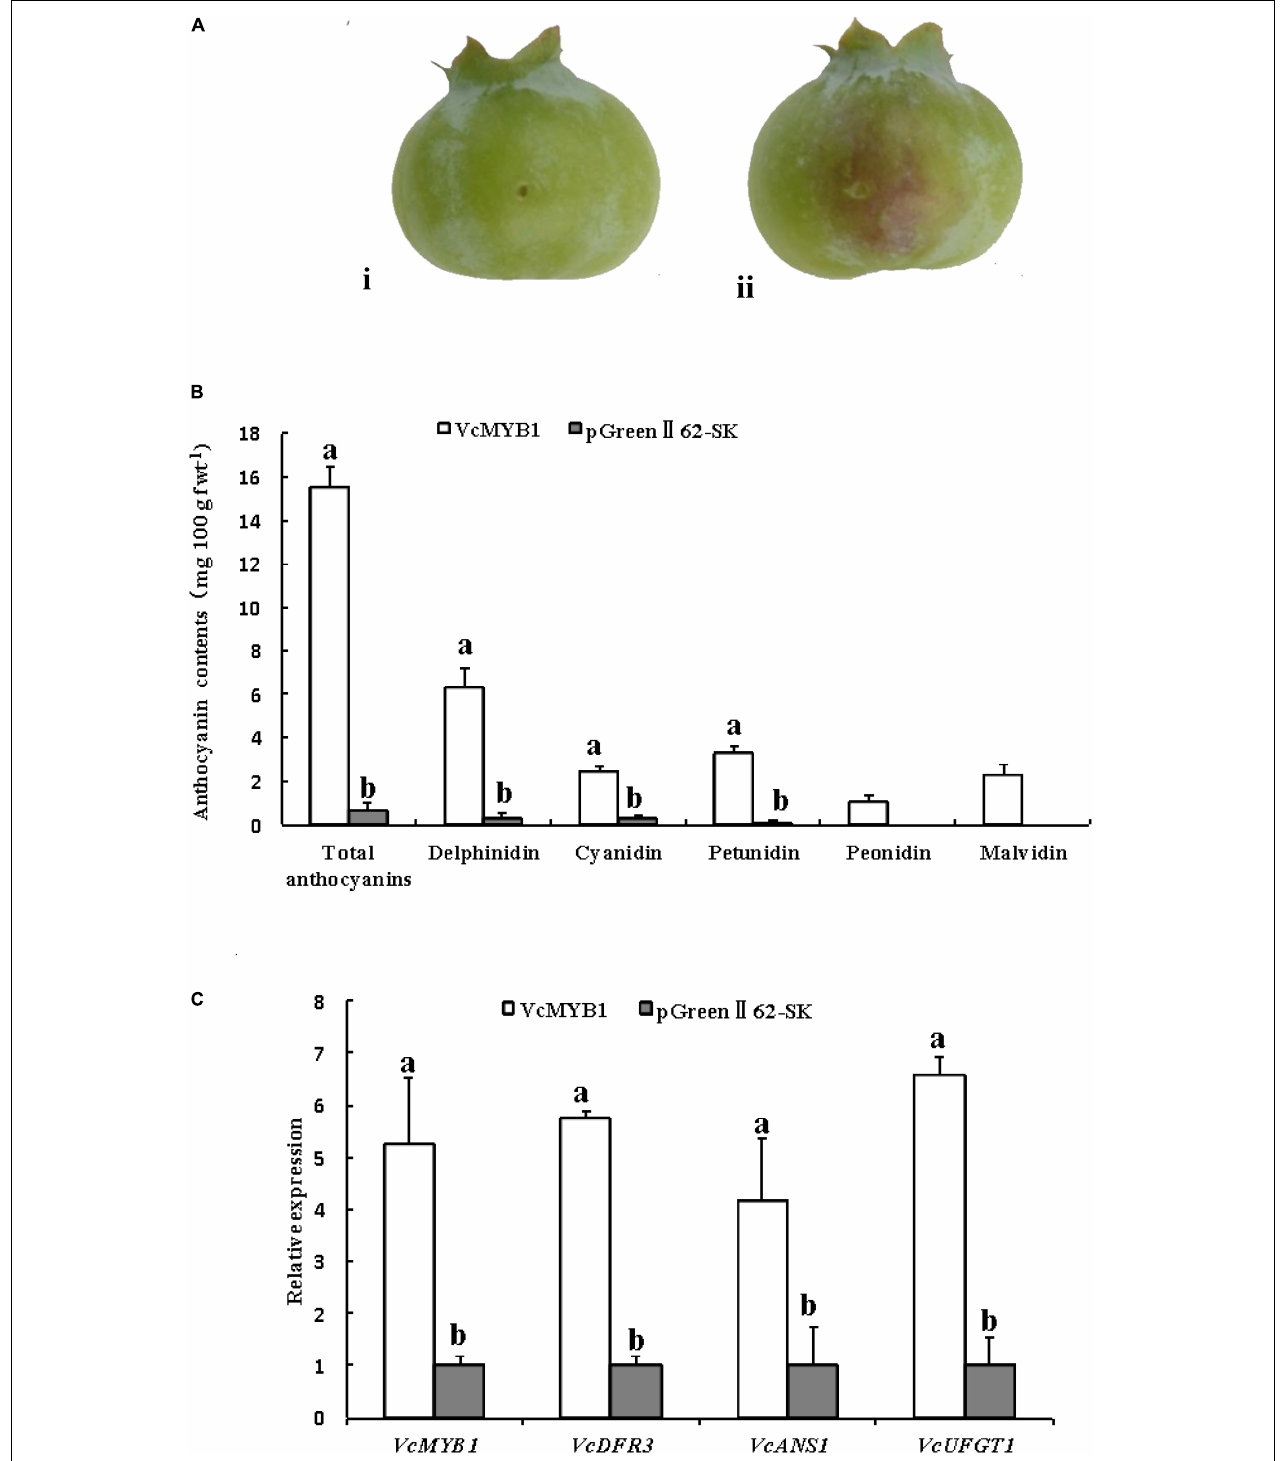
FIGURE 5 | Functional analysis of VcMYB1 in blueberry. (A) blueberry overexpressing (i) pGreenII62-SK fruit and (ii) VcMYB1-pGreenII62-SK (VcMYB1) fruit. (B) Anthocyanin content of fruits overexpressing VcMYB1-pGreenII62-SK (VcMYB1) and pGreenII62-SK fruit. The mean ± SE of biological triplicates were taken for every value. Different English letters represents that the t -test difference was significant. P < 0.05. (C) Relative expression of VcMYB1, VcDFR3, VcANS1 , and VcUFGT1 in fruits overexpressing VcMYB1-pGreenII62-SK (VcMYB1) and pGreenII62-SK fruit. The mean ± SE of biological triplicates were taken for every value. Different English letters represents that the t -test difference was significant P <